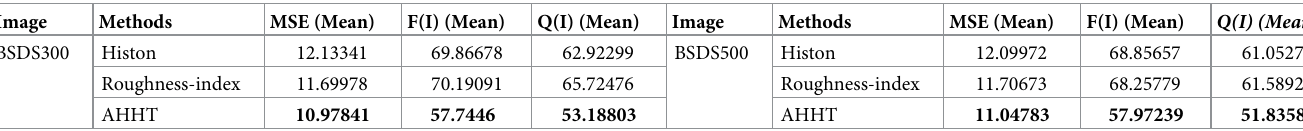
Table 4. Comparison average of MSE , F ( I ) and Q ( I ) on BSDS300 and on BSDS500. Image